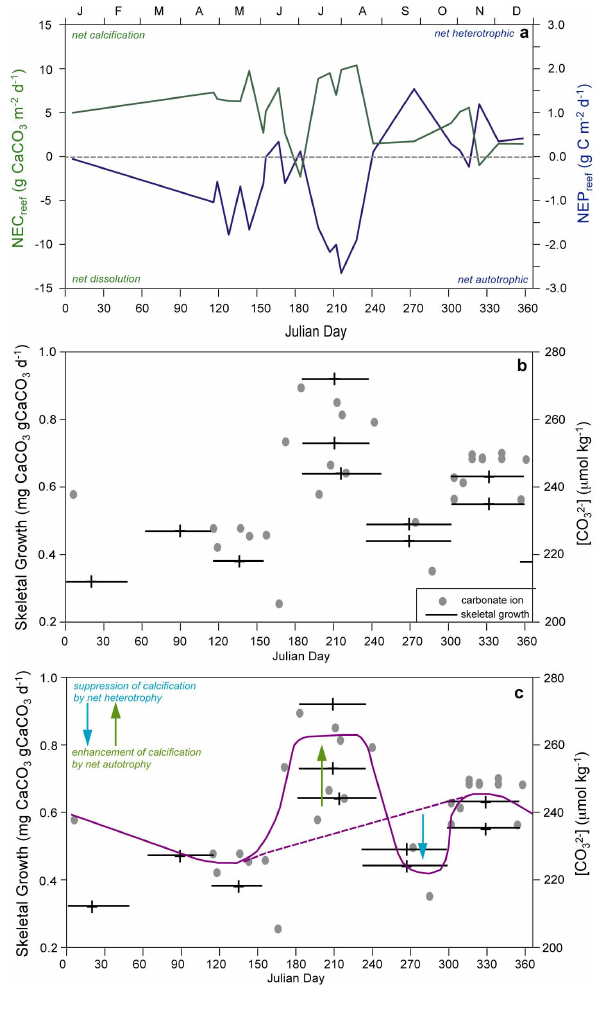
Fig. 5. (a) Annual composite of rates of NEC reef (gCaCO 3 m − 2 d − 1 ; green line) and NEP reef (gCm − 2 d − 1 ; blue line) for the Bermuda reef using seawater TA and DIC data from Hog Reef and BATS, and the alkalinity anomaly-water mass residence technique. Positive NEC reef values represent net calcification, and negative values represent net dissolution, with the zero line denote by grey dashed line. Positive NEP reef values represent net heterotrophy, and negative values represent net autotrophy, with the zero line denote by grey dashed line. (b) Annual composite and comparison of surface seawater [CO 2 − ] 3 data (µmoleskg − 1 ; gray circles) and skeletal growth rates (i.e., G diploria ; mgCaCO 3 g − 1 d − 1 ) . (c) Repeat of panel b showing the CREF hypothesis superimposed on Hog Reef data. In early summer, enhancement of [CO 2 − ] and calcification during June and 3 July [green arrow] occurs due to negative NEP. In late summer, suppression during September and October on the Bermuda reef due to positive NEP [blue arrow]. The dashed line illustrates the hypothesized [CO 2 − ] in absence of the feedback on carbonate 3 chemistry due to seasonal changes in NEP. (d) Seasonal composite of alkalinity difference (i.e., 1 nTA offshore − onshore ) between Hog Reef and the BATS site for the periods 2002–2003 (square symbol) and 2005–2006 (circle symbol).